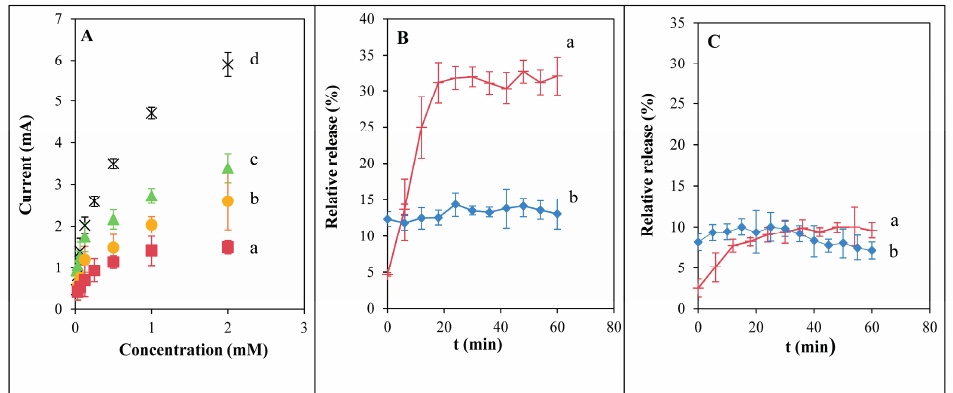
Figure 2 . ( A ) Calibration curves of doxorubicine determined in phosphate buffer pH 7.4 with various content of serum as follows: (a) 0%, (b) 5%, (c) 7.5%, and (d) 10%; ( B ) Current signals of the released doxorubicin (related to the enclosed concentration) from liposome (a) and apoferritin (b) in phosphate buffer at pH 7.4 over a 60-min period; ( C ) Current signals of the released doxorubicin from liposome (a) and apoferritin (b) in 5% serum phosphate buffer at pH 7.4 over a 60-min period. Displayed as a mean ±